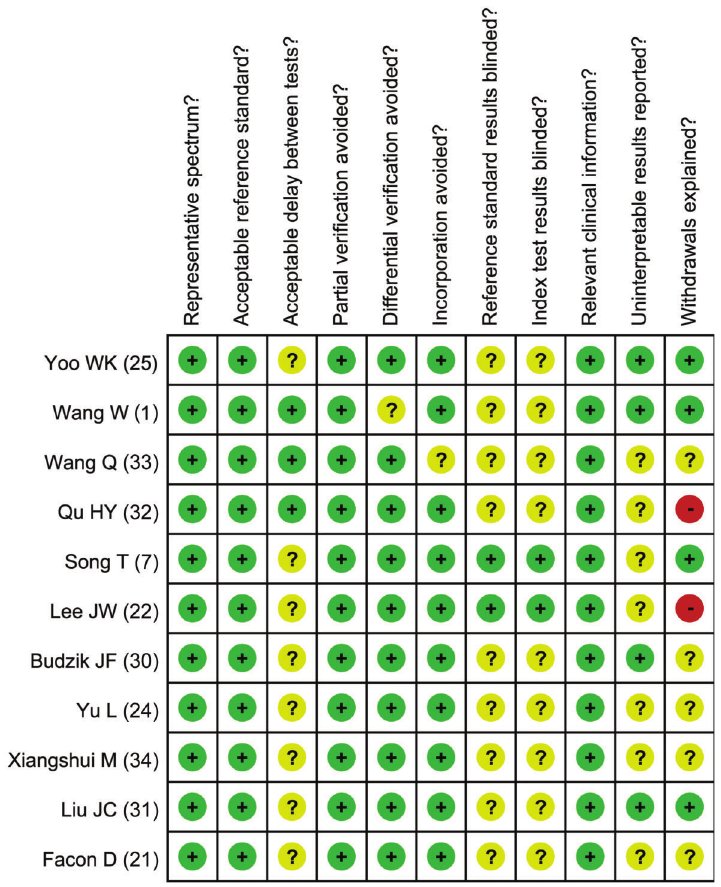
Figure 1. Methodological quality assessment for each of the included case-control studies on the basis of the Quality Assessment of Diagnostic Accuracy Studies (QUADAS)